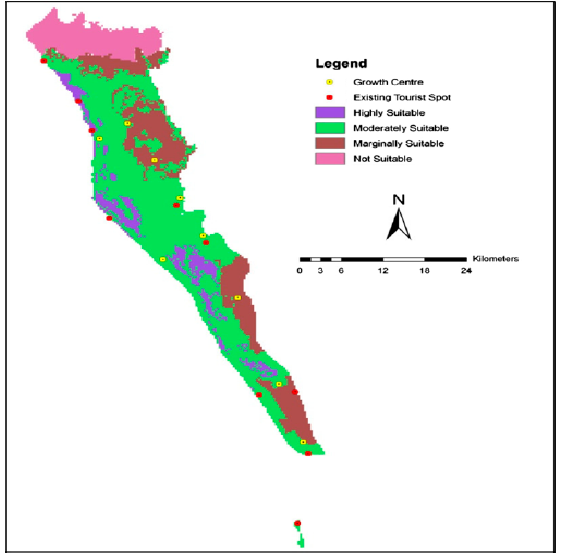
Figure 4 : Land suitability for map ecotourism in Cox’ Bazar, Source by Ullah and Hafiz